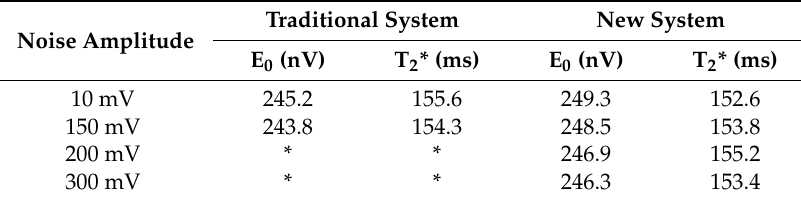
Table 3. The experimental results in laboratory.